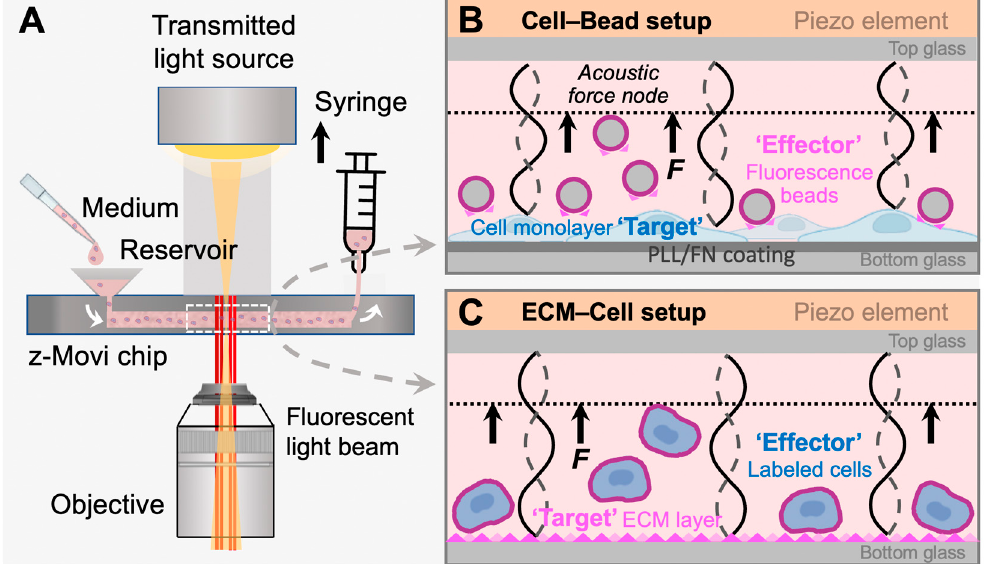
Figure 1. z-Movi working principle. ( A ) z-Movi utilizes a piezo-embedded microfluidic chip to perform the cell avidity measurement. The targets and effectors in the cell medium will be injected into the reservoir and then flushed into the flow chamber by pulling the syringe attached to the outlet of